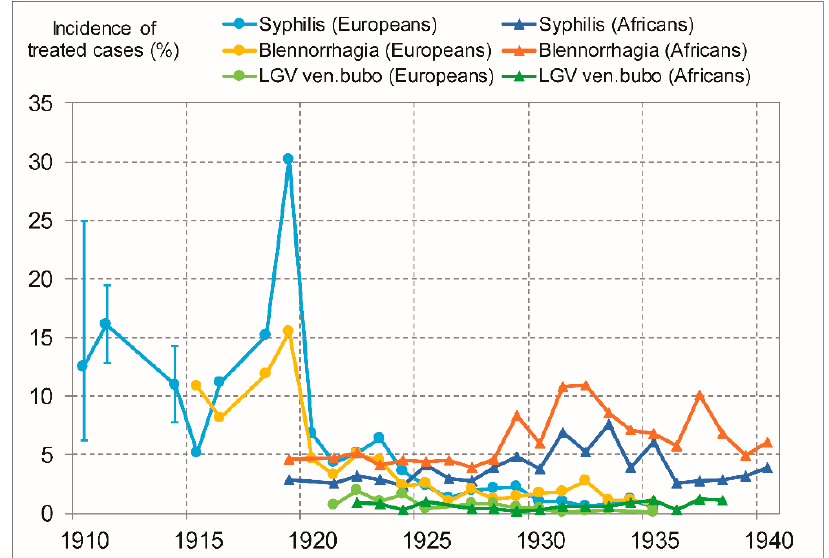
Figure 1. Incidence of treated cases (in %) of several STD conditions in Leopoldville’s European and African adults (only males for chancroid and LGV venereal bubo). For details, see main text. The data supporting this figure are presented in Supplementary Dataset S1. The error bars for the years 1910, 1911, and 1914 for syphilis represent our lower and upper estimates, explained in Supplementary Text S1. For years without error bars, the data point represents the single reported value extracted from the archives.